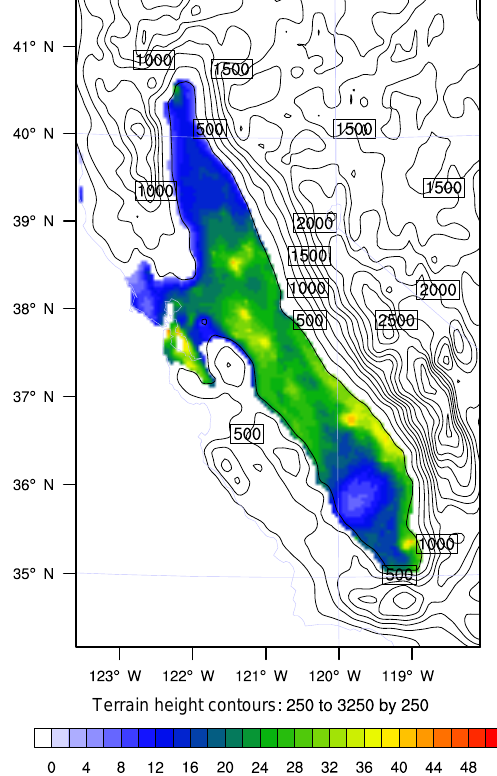
Figure 5. The 72h averaged (16–18 January 2011) AQC number concentration averaged over the first five model layers from the ex- periment S_ARon_CRmod in units of 10 8 #m − 3 . Contours are ter- rain heights in m.